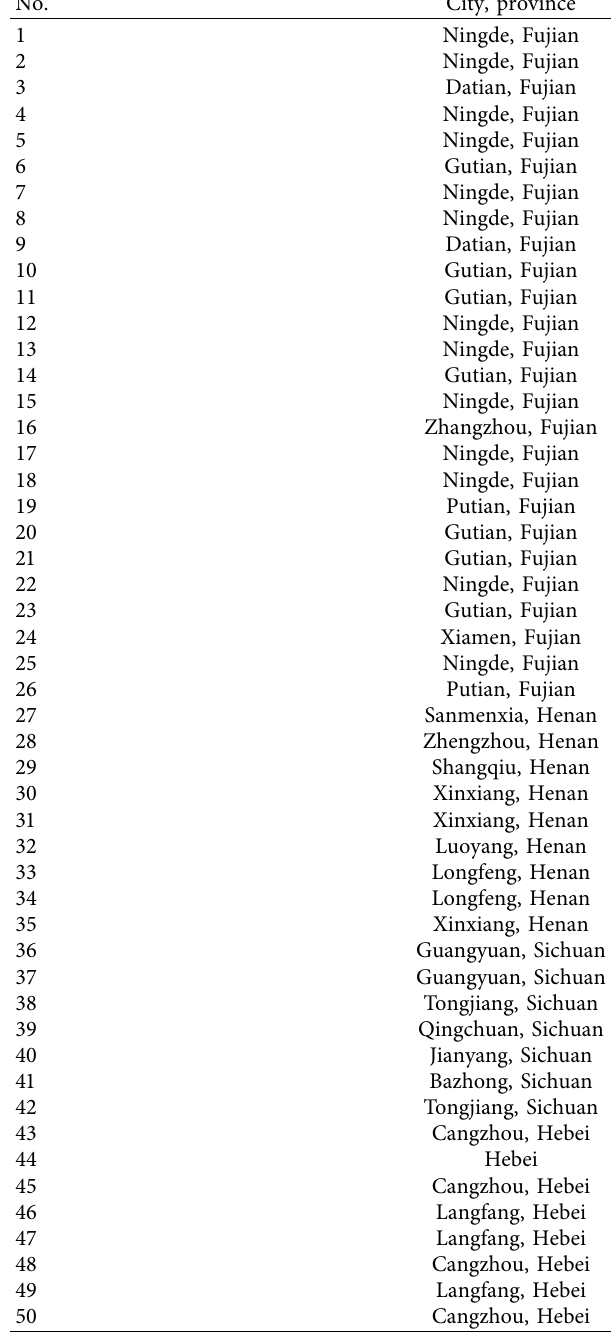
Table 1: Origin regions of T . fuciformis